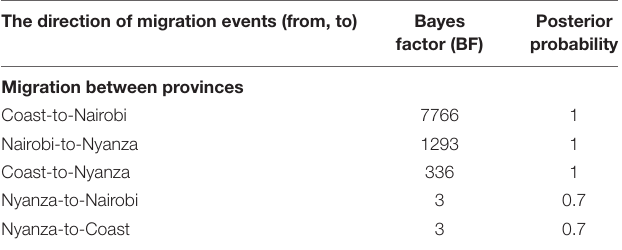
TABLE 4 | HIV-1 migration rates (Bayes factor, BF ≥ 3) between geographic locations in